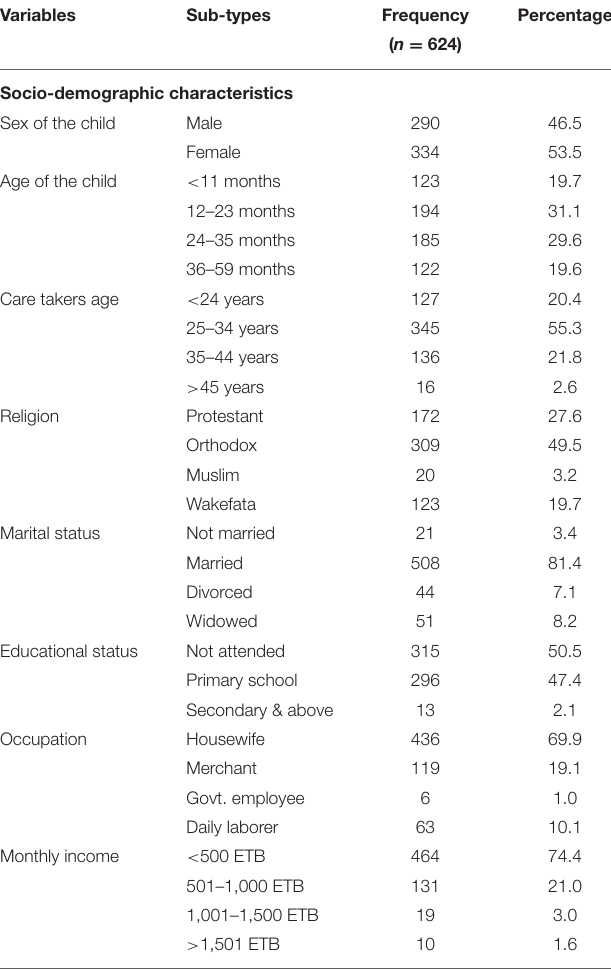
TABLE 1 | Socio-demographic characteristics of the study participants in Dandi Woreda, West Shewa, Ethiopia, 2022.